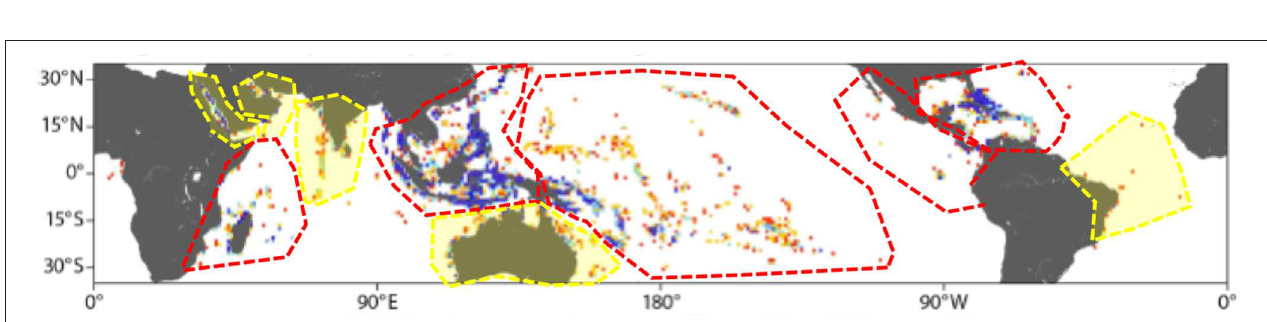
FIGURE 1 | Integrated monitoring for the GCRMN, illustrating the primary areas of focus for monitoring (variables that measure reef state, key pressures and impacts), sandwiching these in a DPSIR (Driver Pressure State Impact Response) framework. The DPSIR framework explicitly asserts key societal questions and drivers so monitoring outputs inform necessary responses in an adaptive management framework. Sources: UNESCO (2012), UNEP/SPAW (2017).